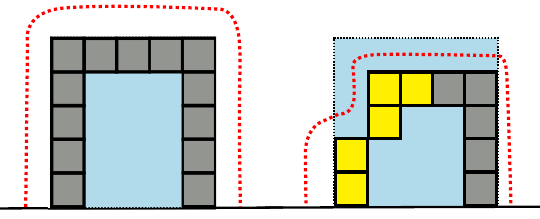
Figure 1. The MAV’s movements are constrained to a hull (red dotted line) that is initially built around the user-specified bounding box (blue area), then is adapted according to the new explored (yellow squares) and unknown (gray squares) voxels.